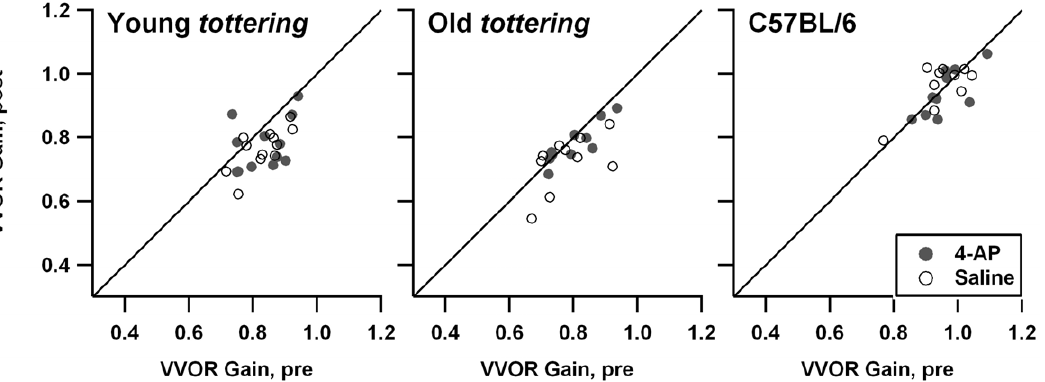
Figure 1. Comparison of visually enhanced vestibulo-ocular reflex (VVOR) gain before and after saline (open symbols) or 1.25 mg/ kg 4-AP. Each animal cohort is represented in a separate plot. Diagonal line indicates a 1:1 post-treatment:pre-treatment relationship. Mutants exhibited some decline in gain from pre-treatment to post-treatment, suggesting habituation. There was no effect of 4-AP.